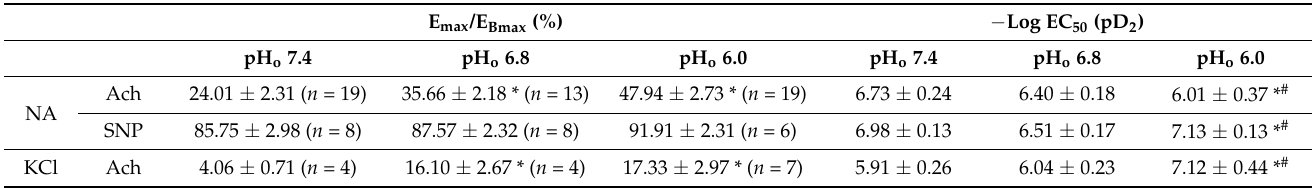
Table 2. Ach- or SNP (1 nM–100 µ M)-induced vasorelaxation on NA- (10 µ M) or KCl (60 mM)- precontracted SMA rings at pH o 7.4, 6.8, and 6.0. The data presented as mean ± SE. n = no of experiments. E max /E Bmax (%) − Log EC 50 (pD 2